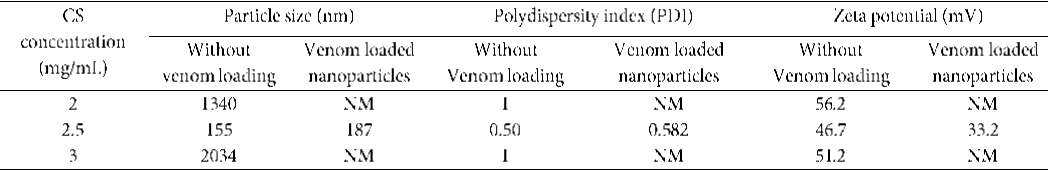
Table 1. Particle size, PDI and zeta potential of CS-NPs and venom-loaded by